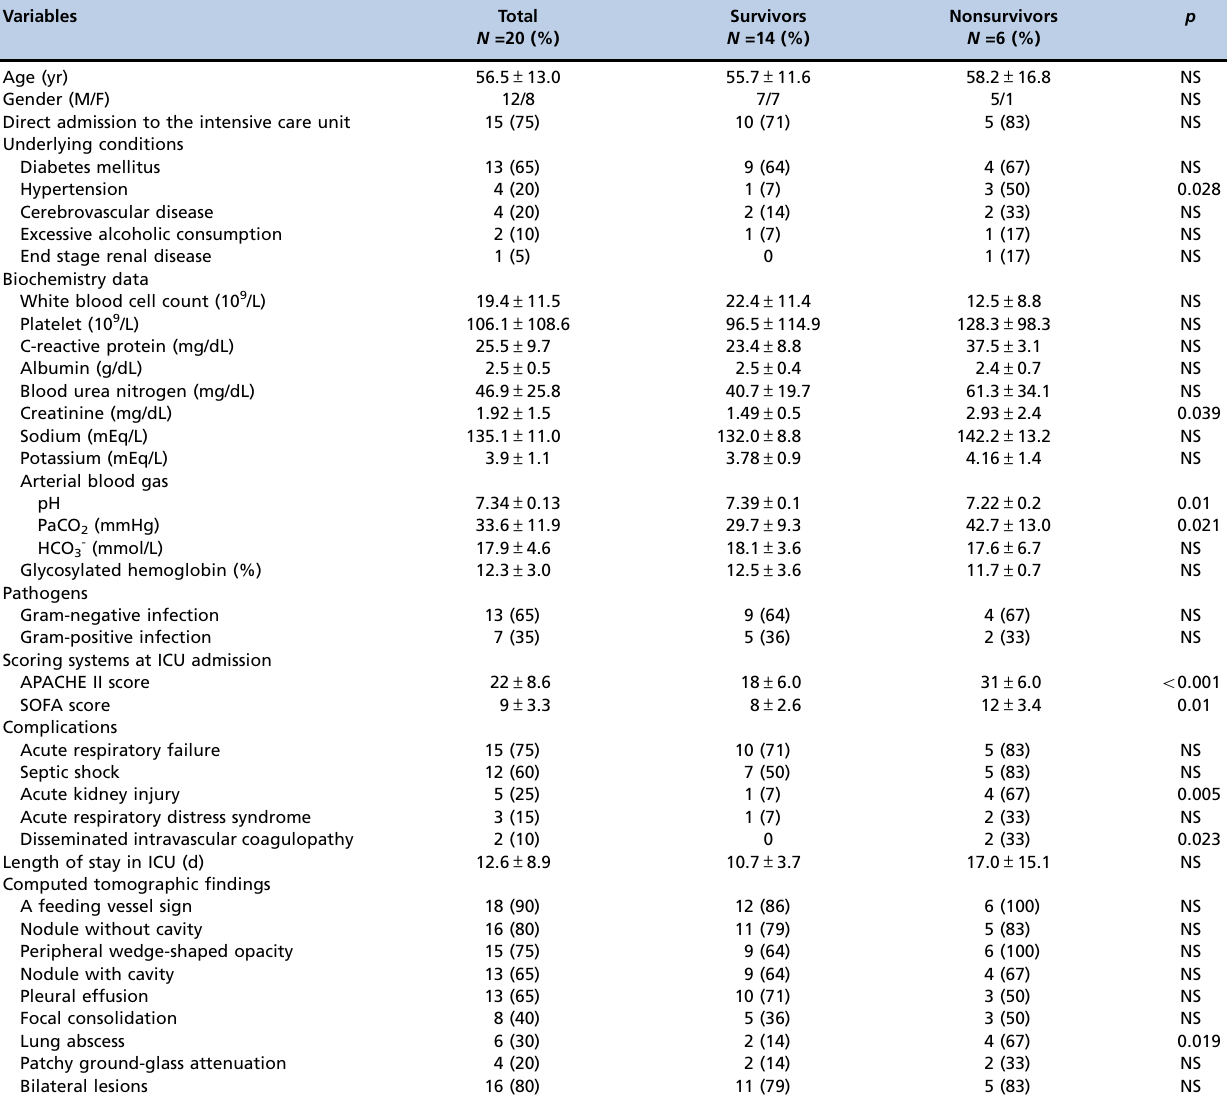
Table 1 - Comparison of clinicoradiological characteristics between survivors and nonsurvivors.